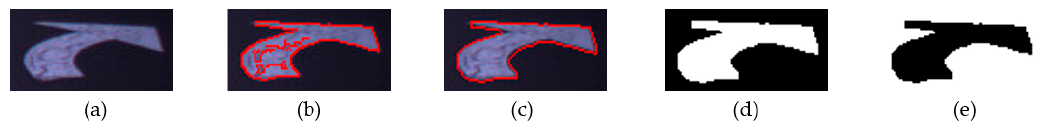
Figure 7. Results of the visibility analysis module. ( a ) Original patch, including the pavement marking; ( b ) Found contours without the dilation operation; ( c ) Found contours with the dilation operation; ( d ) Generated image mask for the marking; and ( e ) Generated image mask for the pavement.